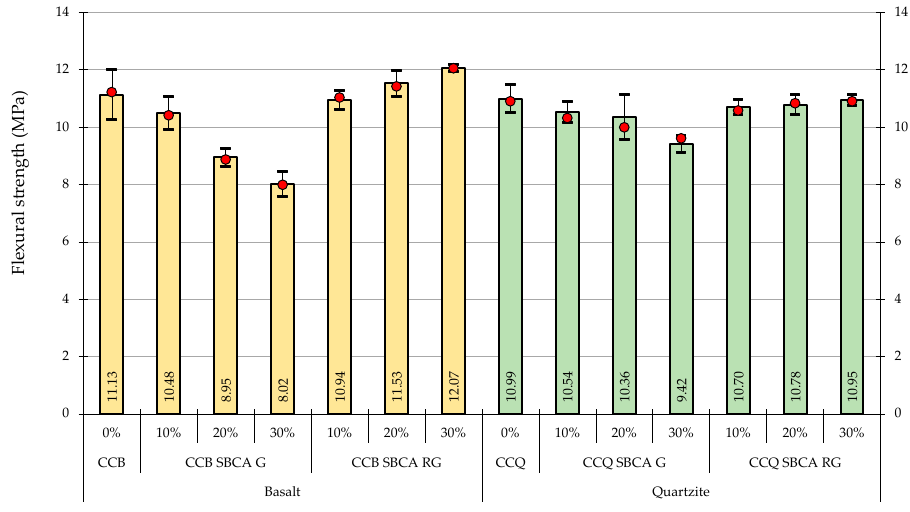
Figure 18. Flexural strength mortars with reactive aggregates before the ASR test.